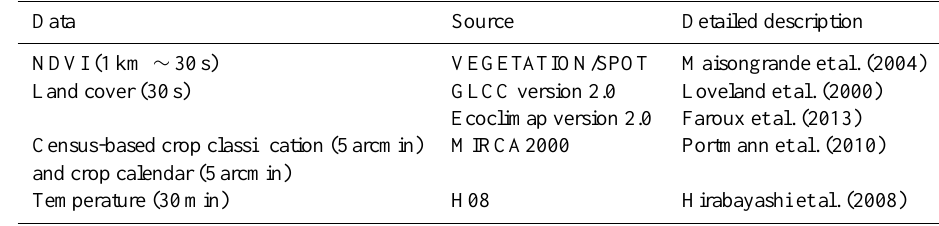
Table 1. Characteristics and sources of the four global input data sets.